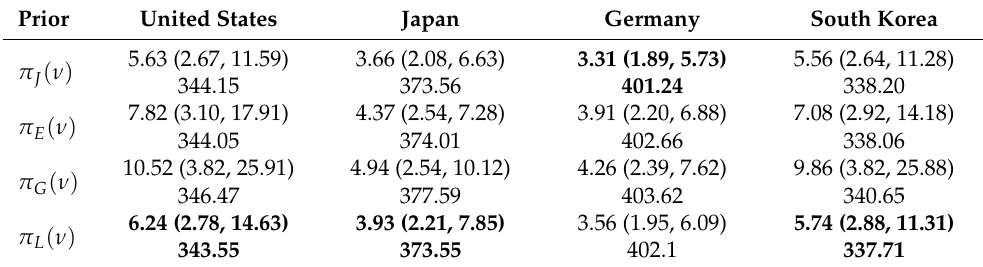
Table 3. Estimation results based on the four